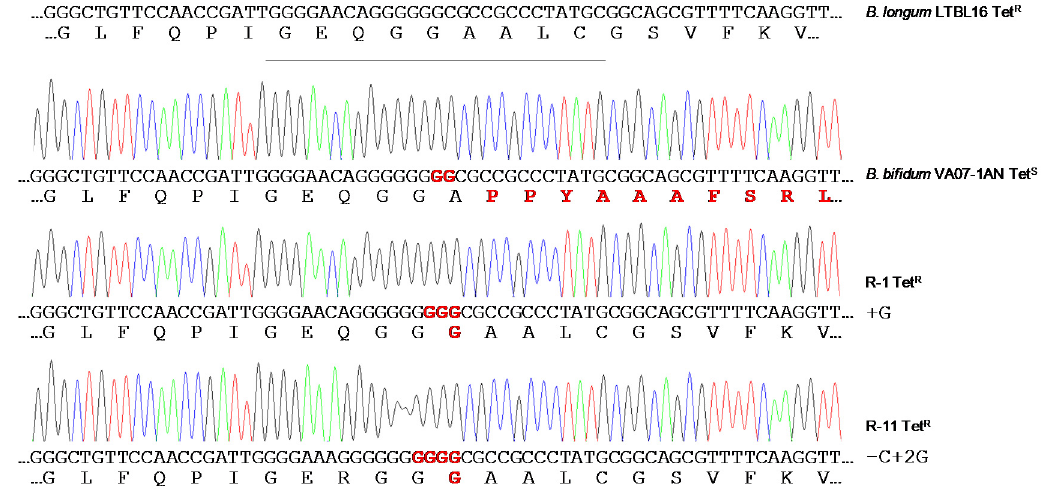
Figure 5. Chromatograms of amplicons of the tet (W) gene from the original tetracycline-susceptible strain B. bifidum VA07-1AN and two representative tetracycline-resistant revertants (R-1 and R-11). Nucleotide sequences and the corresponding deduced amino acid sequences are displayed below each of the chromatograms. DNA and protein differences with canonical sequences of the tet (W) gene from the tetracycline-resistant Bifidobacterium longum LTBL16 strain (on top of the figure) are highlighted in red.